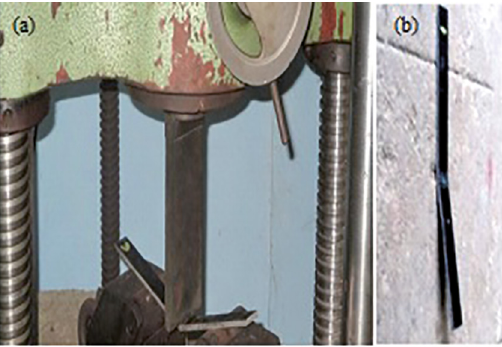
Figure 4: Flexural test (a) UTM setup (b) specimen after fracture